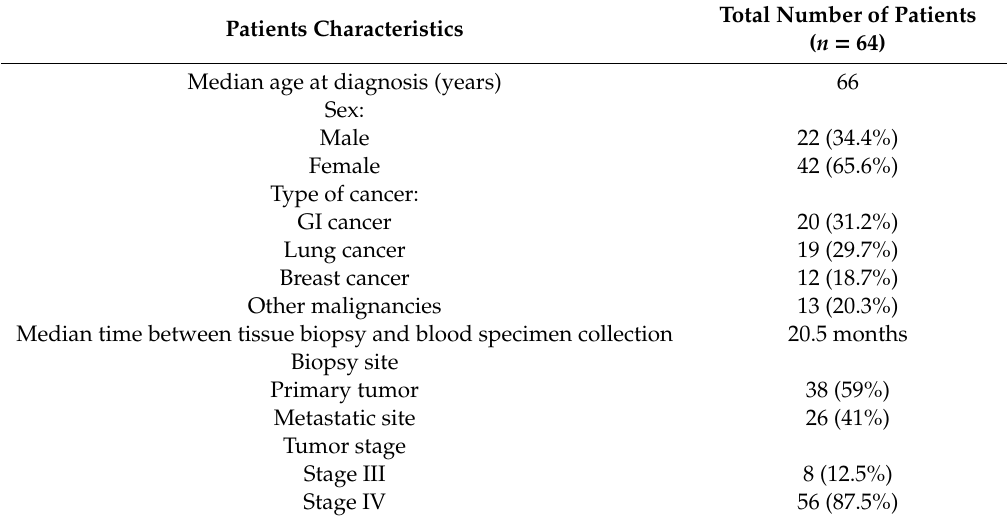
Table 1. Patient